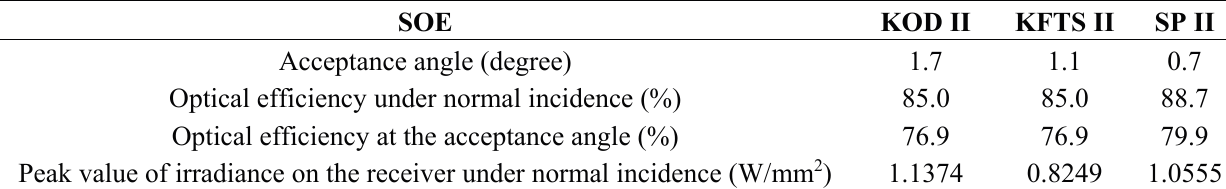
Figure 21. Optical efficiency of the Fresnel lens with three optimum SOEs. Table 4. Optical characteristics of the CPV unit with three optimum